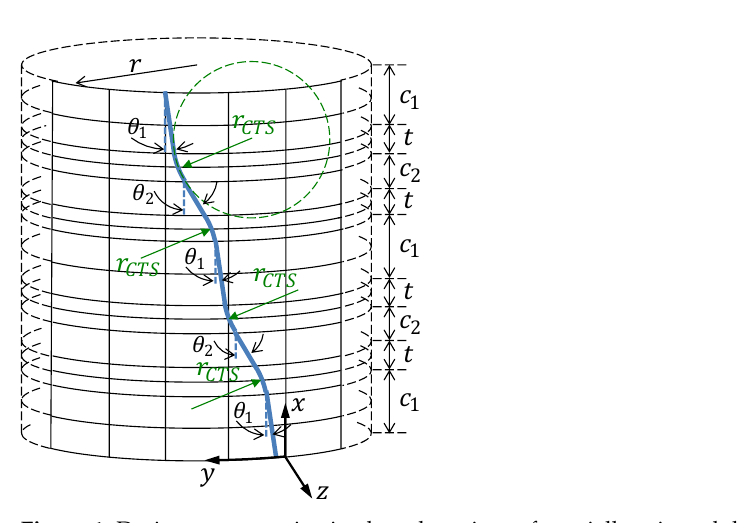
Figure 1. Design parameterization based on circumferentially oriented thickness